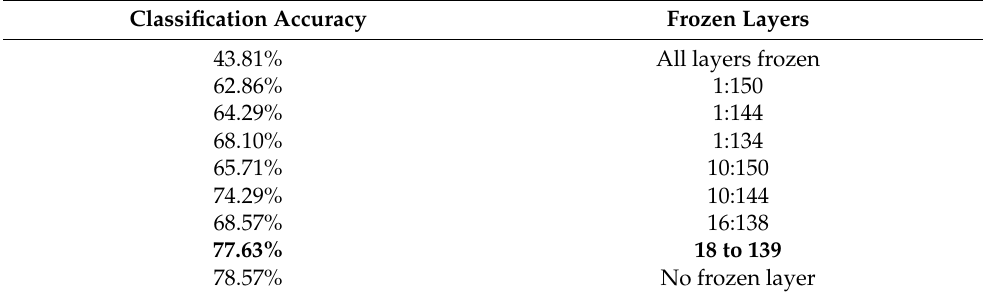
Table 6. Classification accuracy of MobileNetV2 with an overall of 154 layers on tactile data for different frozen